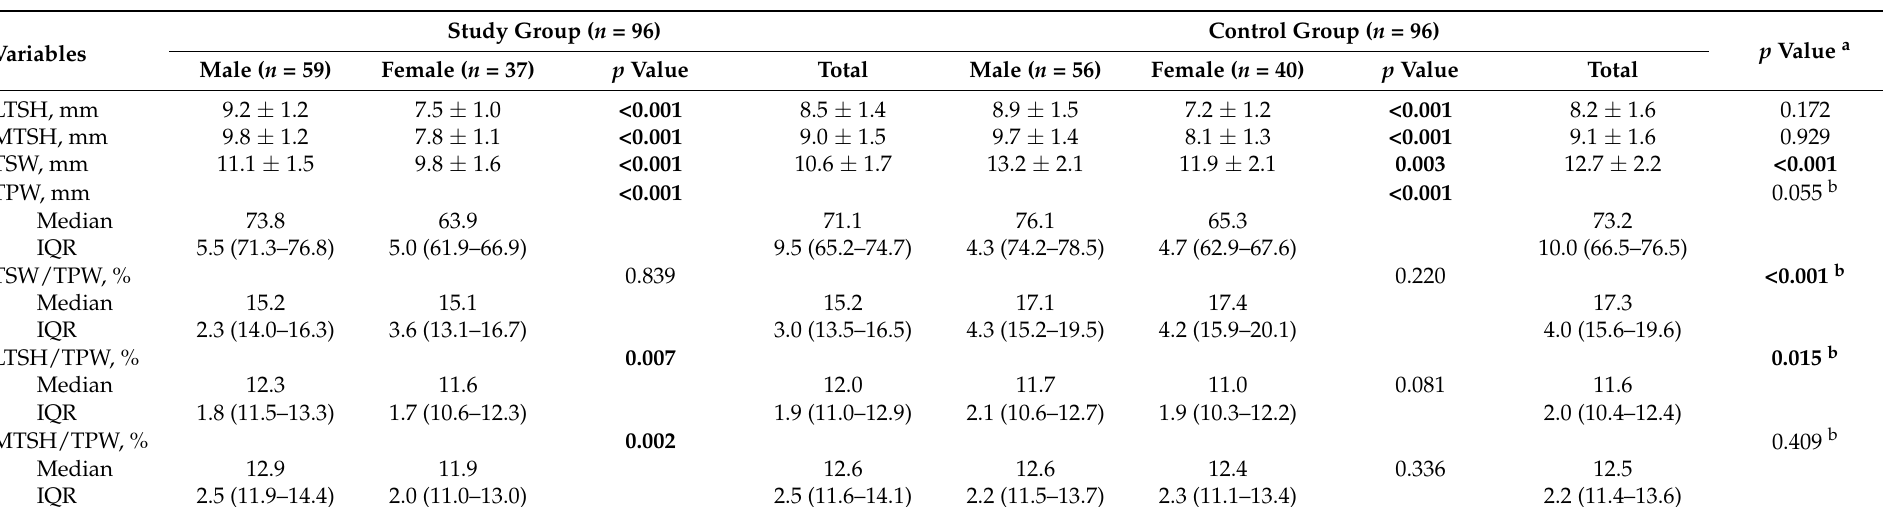
Table 3. Comparison of the variables between subgroups, showing the mean ± SD or median